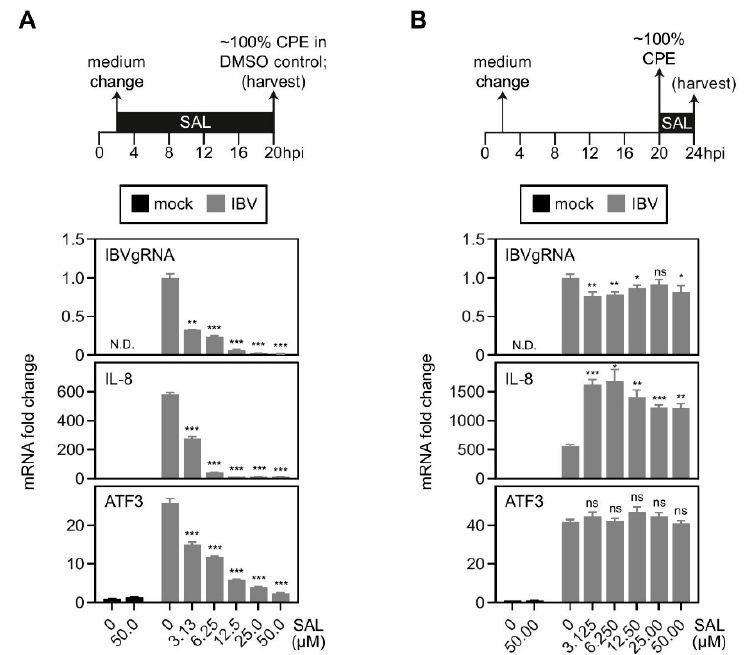
Figure 4. Treatment of eIF2 α phosphatase inhibitor, salubrinal, increased the induction of IL-8 mRNA in cells infected with IBV. ( A ) H1299 cells were infected with IBV at MOI~2 or mock infected. Two hours after adsorption, culture medium was changed and cells were treated with salubrinal at the indicated concentrations or the same volume of DMSO. Cells were harvested at 20 hpi and total RNA samples were extracted for RT-qPCR. The levels of IL-8, ATF3, and IBV genomic RNA were determined by the ΔΔ Ct method using the GAPDH mRNA of the DMSO-treated and mock-infected sample for normalization. The experiment was repeated three times with similar results, and the result of one representative ex- periment is shown. Significance levels were presented by the p -value (**, p < 0.01; ***, p < 0.001; N.D., non-determined). ( B ) H1299 cells were infected with IBV at MOI~2 or mock infected. Culture medium was changed two hours after adsorption. When 100% CPE was observed in the infected cells at 20 hpi, cells were treated with salubrinal at the indicated concentra- tions or the same volume of DMSO for 4 h. Cells were harvested and RT-qPCR was performed as in ( A ). The experiment was repeated three times with similar results, and the result of one representative experiment is shown. Significance levels were presented by the p -value (ns, non-significant; *, p < 0.05; **, p < 0.01; ***, p < 0.001; N.D.,